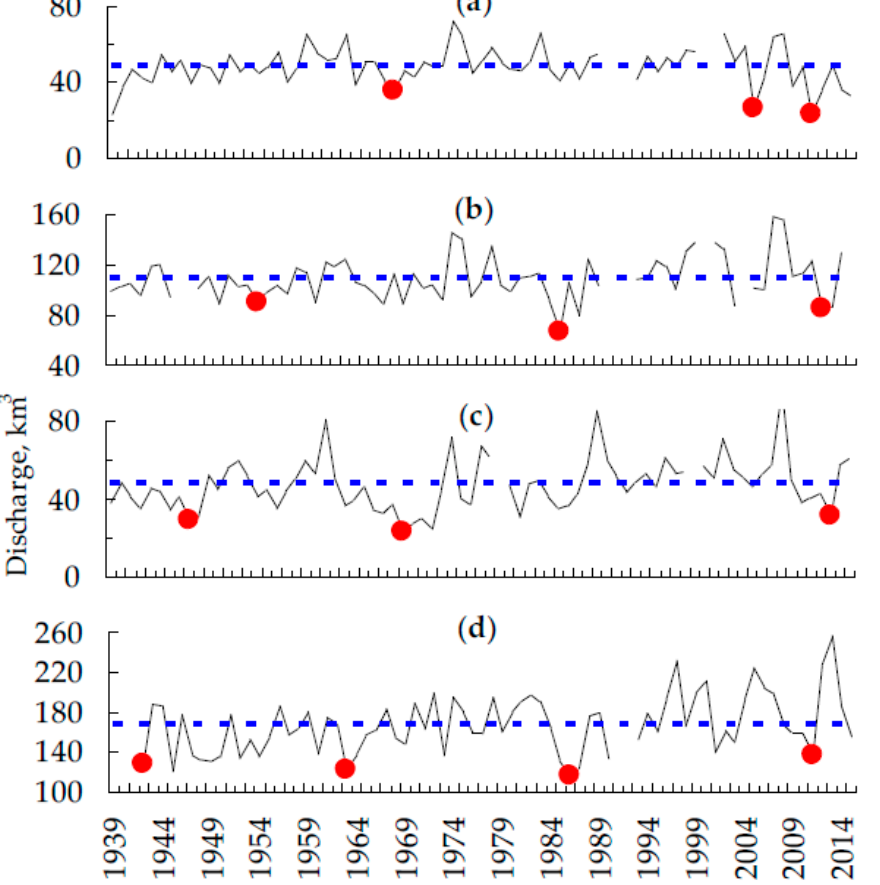
Figure 2. The long-term data on the total annual runoff (km 3 ). The dots indicate the minima, which correspond to the dates of extreme fire events. Dotted line—annual mean value of the discharge per season. Rivers: ( a ) Podkamennaya Tunguska; ( b ) Lower Tunguska; ( c ) Viluy; and ( d ) Aldan.